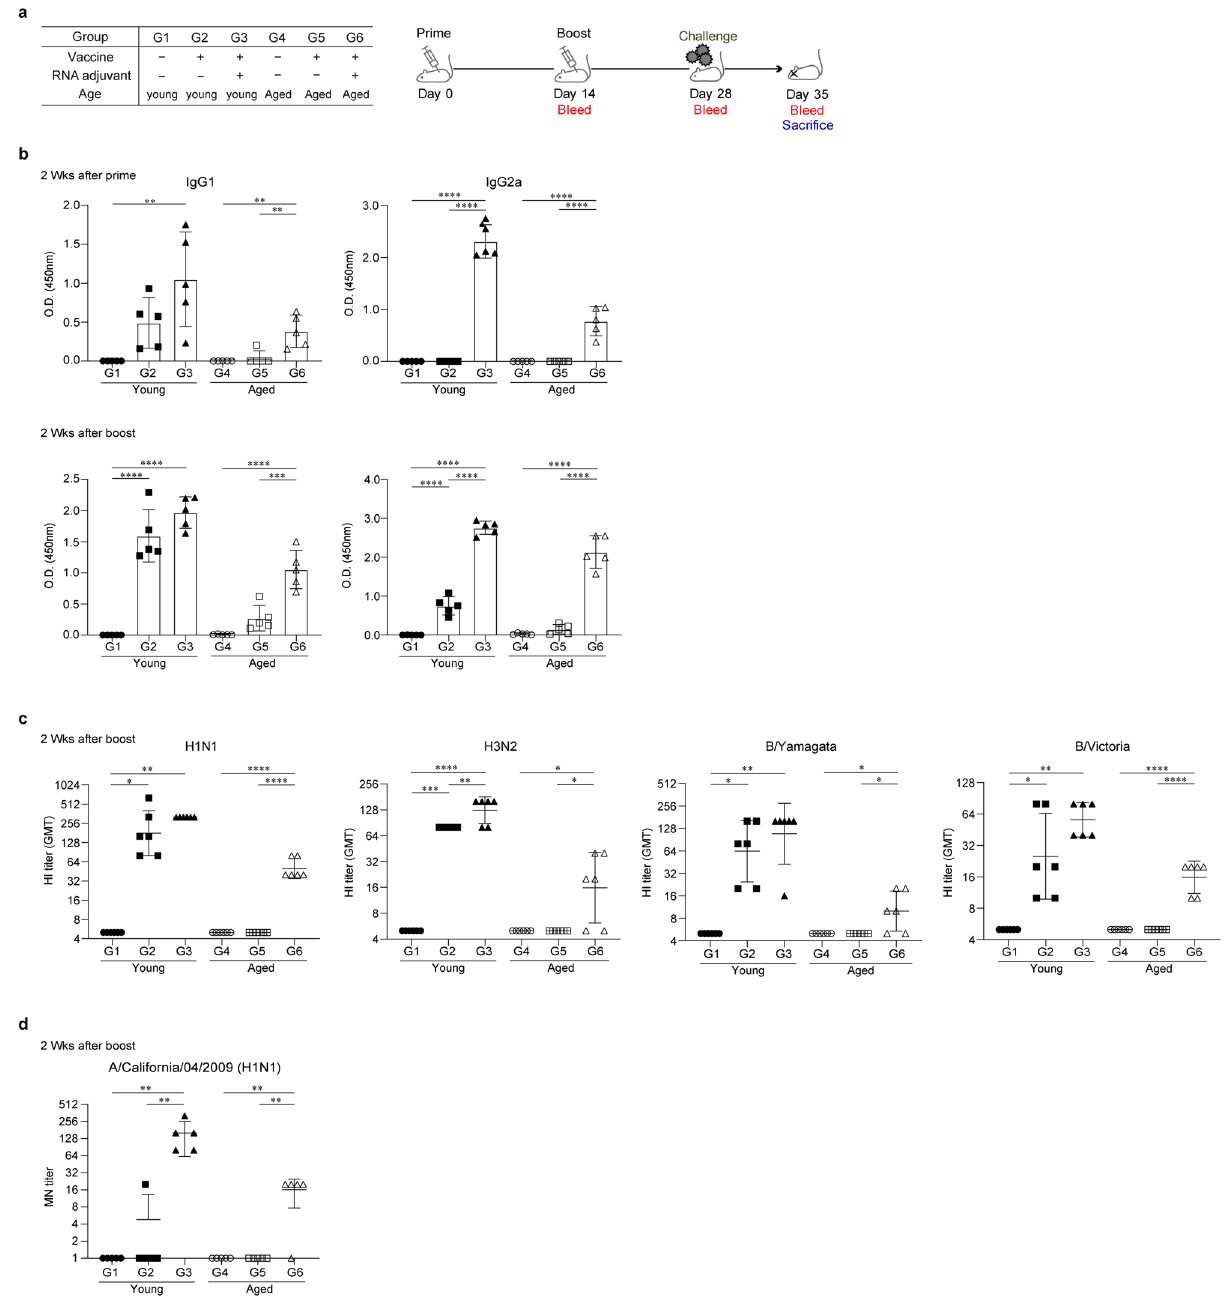
Figure 1. Inactivated influenza vaccine (IIV) formulated with ssRNA augments the IIV-induced humoral responses. BALB/c mice were intramuscularly immunized with 0.6 μg IIV with or without ssRNA adjuvant at an interval of 2 weeks. 2 weeks after the boost schedule, mice were challenged with A/California/04/2009 virus. To perform IgG, IgG2a, hemagglutination inhibition, and microneutralization assays, sera were collected at 2 weeks after the prime and boost schedule. Data are represented as mean ± SD. The data were statistically analyzed by one-way ANOVA. The significance of differences between groups are indicated by bars and symbols as follows: *p < 0.05; **p < 0.01; ***p < 0.001; ****p < 0.0001. ( a ) Immunization groups and schedule for immunization and challenge. n = 5 mice for G1 to G6. ( b ) IIV-specific IgG1 and IgG2a levels measured by ELISA 2 weeks after the prime and boost schedule. n = 5 mice for G1–G6. ( c ) Hemagglutination inhibition titer against vaccine strains measured by hemagglutination inhibition assay 2 weeks after the boost schedule. Data represent geomean of duplicated results. n = 3 mice for G1–G6. ( d ) Microneutralization titer against A/California/04/2009 measured by microneutralization assay 2 weeks after the boost schedule. n = 5 mice for